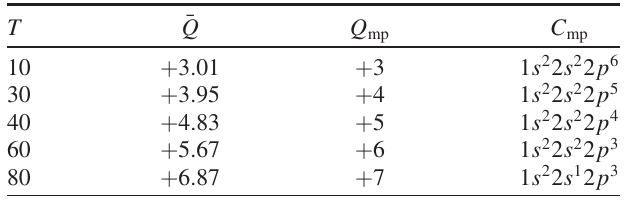
¯ Q TABLE III. Average charge state , the most probable charge , and the most probable bound-electron configuration state Q mp C for a given temperature T from the first step of two-step HFS mp calculation. Note that C is the ground configuration for a given mp charge state, except Al 7 þ at T ¼ 80 eV.